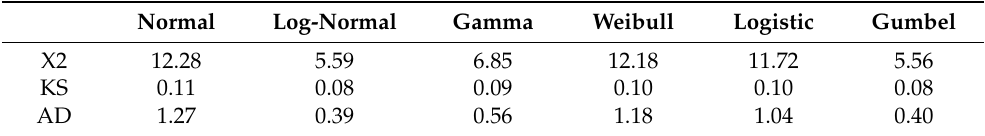
Table 2. Statistical test results of the